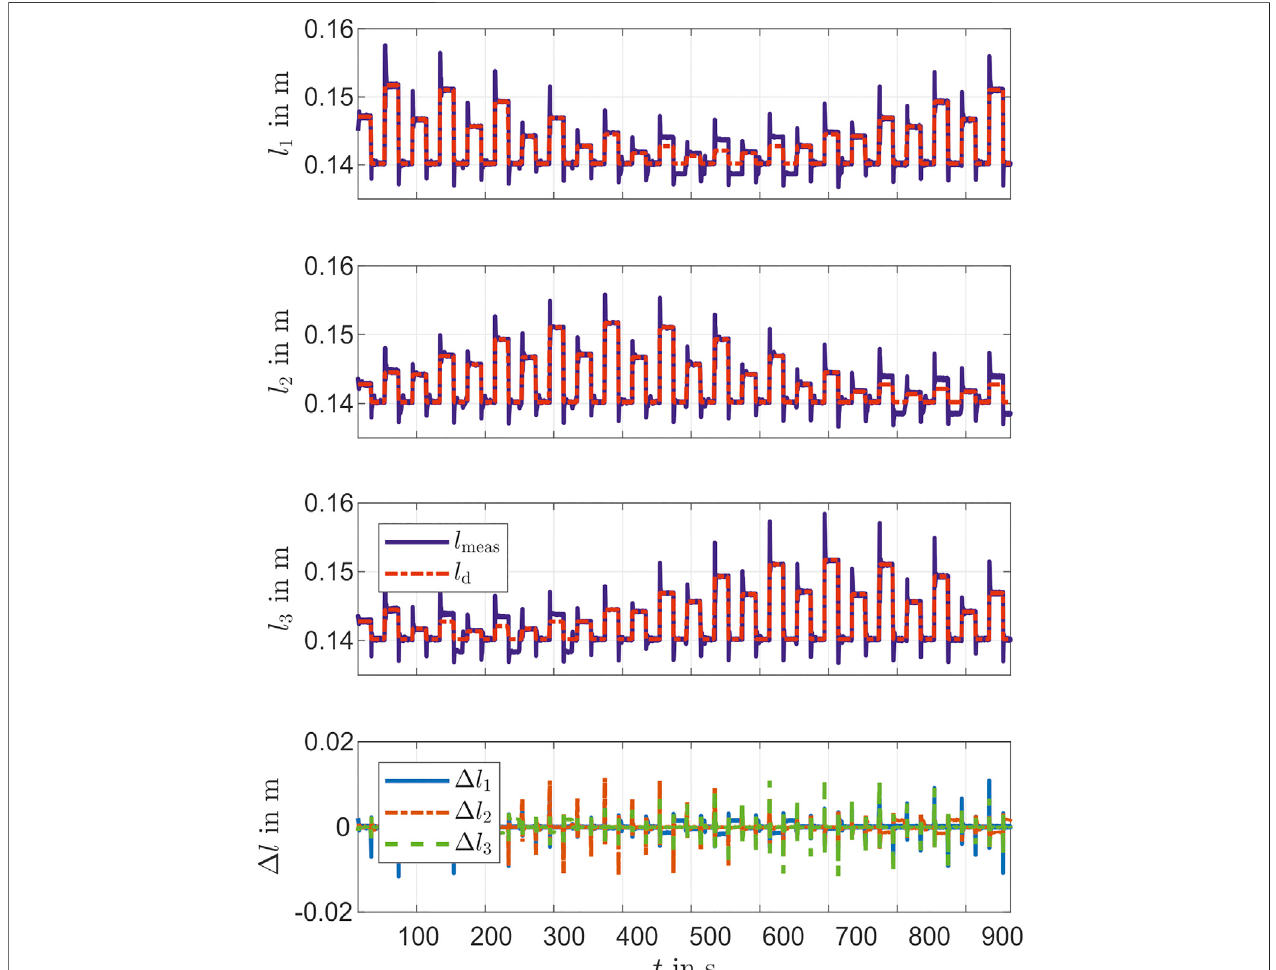
FIGURE 7 | Desired and measured values of the chambers ’ lengths during validation of PID Controller.